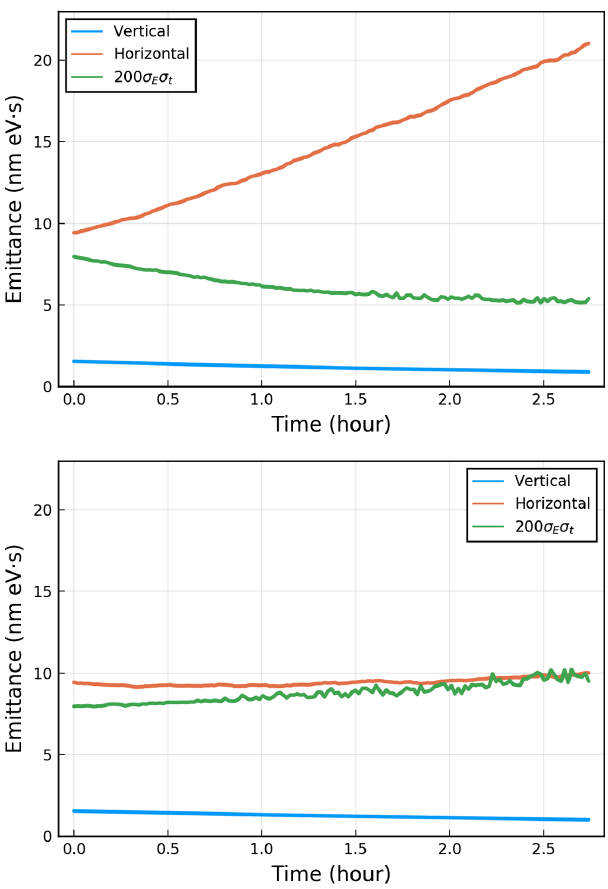
FIG. 10. Evolution of the rms electron beam size and angle spread along the cooling section with and without the space charge effect ( β (cid:3) i ¼ 100 m).